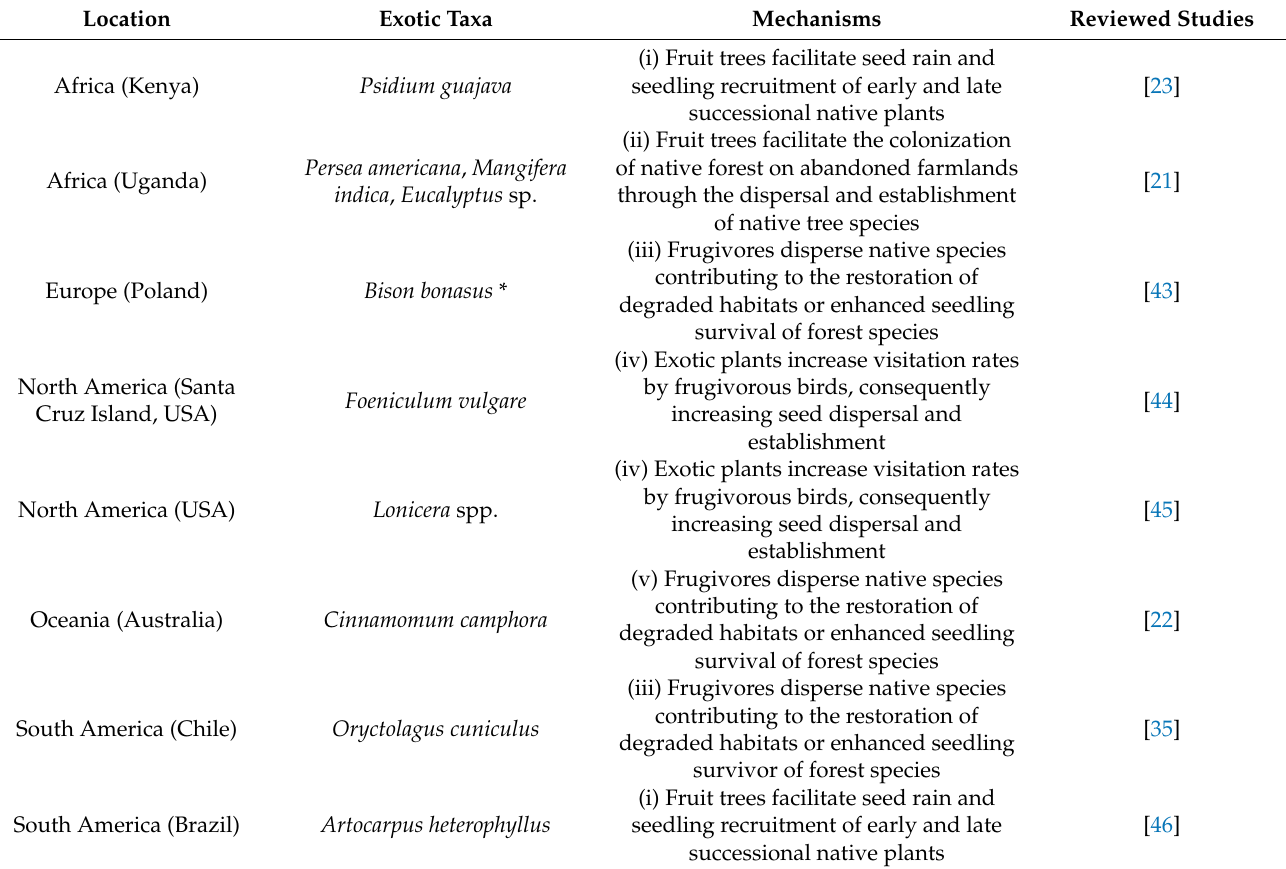
Table 2. Exotic taxa involved in forest regeneration and restoration of degraded habitats